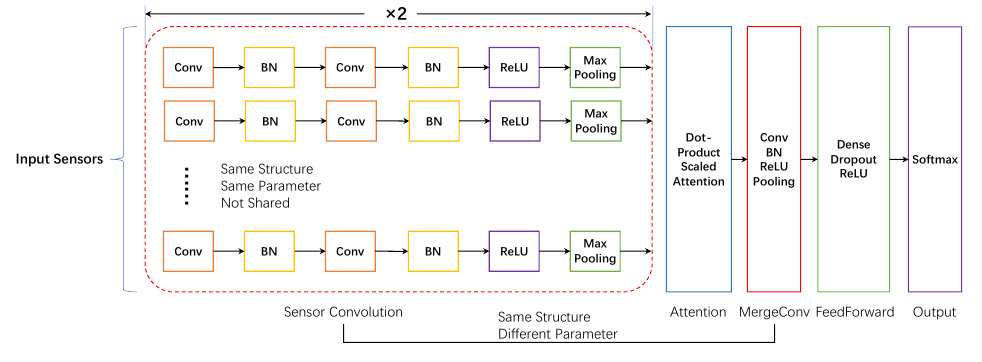
Figure 1. The Overall Structure of